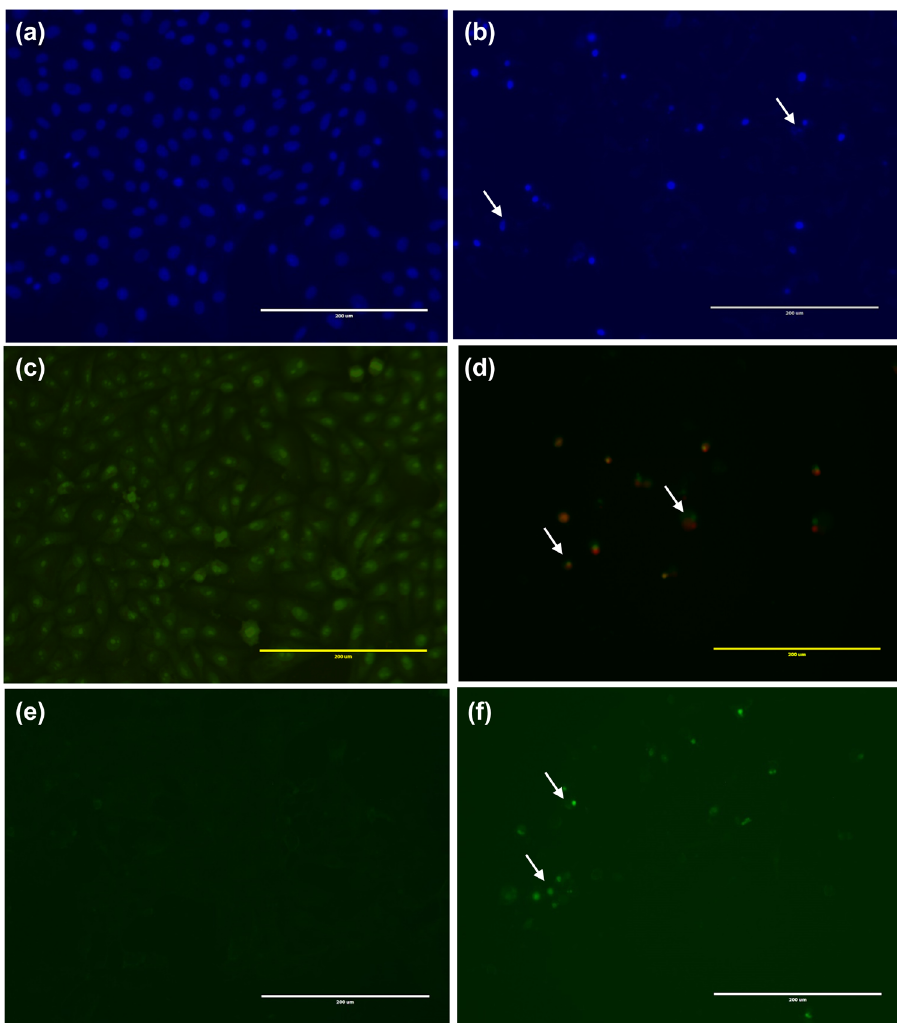
Figure 4: Fluorescence image of MCF - 7 cells treated with DAPI, AO/EB, or caspase - 3/7 regent after 24 h of treatment with 7b. DAPI staining shows chromatin condensation and nuclear fragmentation as indicated with arrows. ( a ) Untreated cells and ( b ) treated cells. AO/EB staining: ( c ) untreated cells and ( d ) treated cells. Live cells are stained evenly green, whereas apoptotic cells are characterized by shiny green and yellow - orange staining due to loss of membrane integrity and chromatin condensation. Caspase - 3/7 activation: ( e ) untreated cells and ( f ) treated cells. Caspase - 3/7 activation was demonstrated by green fl uorescence. Magni fi cation ×